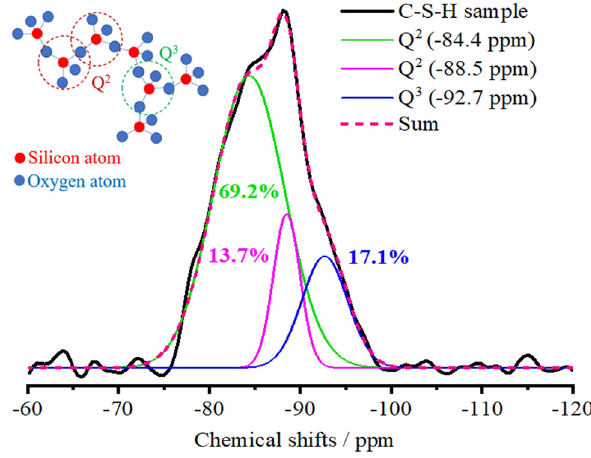
Figure 3: 29 Si CP - MAS NMR spectroscopy results obtained for a representative synthesized C – S – H sample along with the results of chemical shift peak